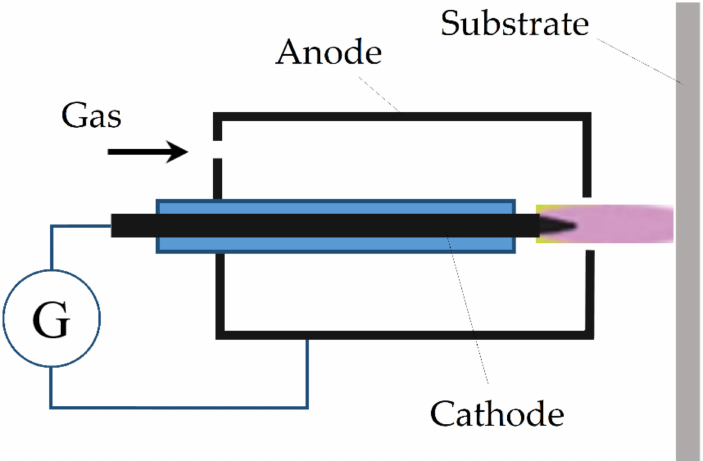
Figure 7. Plasma source for surface